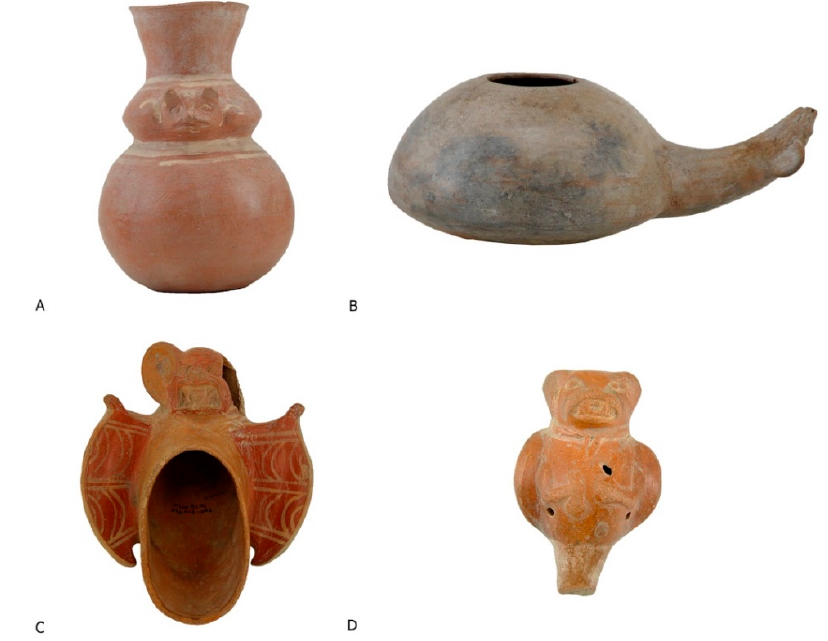
Figure 4. Vessels that have depictions of bats: ( A ) cántaro with bat snout and ears along the neck (ML012348); ( B ) canchero with a bat head at the end of the handle (ML006401); ( C ) bowl as a bat with the opening in the lower abdomen (ML008254); ( D ) whistle depicting bat holding bag and stirrup jar (ML014407) (Museo Larco, Lima—Perú).